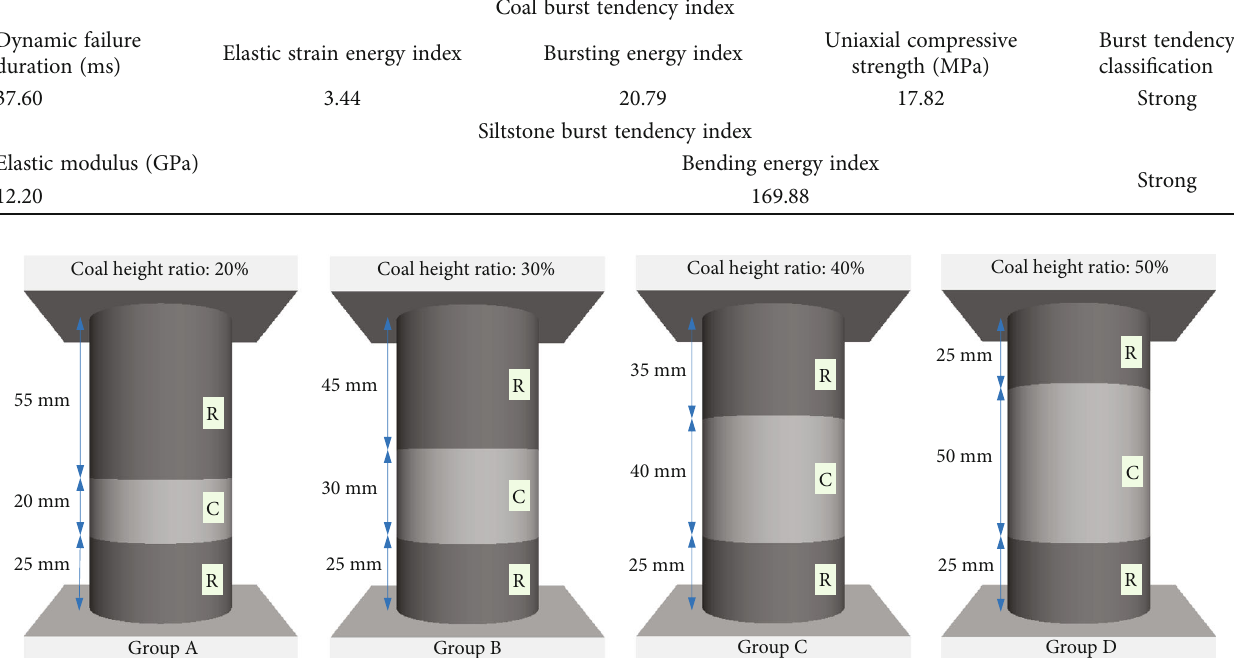
Figure 1: group “ A ”— coal height ratio 20%, group “ B ”— coal height ratio 30%, group “ C ”— coal height ratio 30%, and group “ D ”— coal height ratio 50%. The height of fl oor siltstone samples was always 25 mm, while the height of roof siltstone samples changed with the coal height.